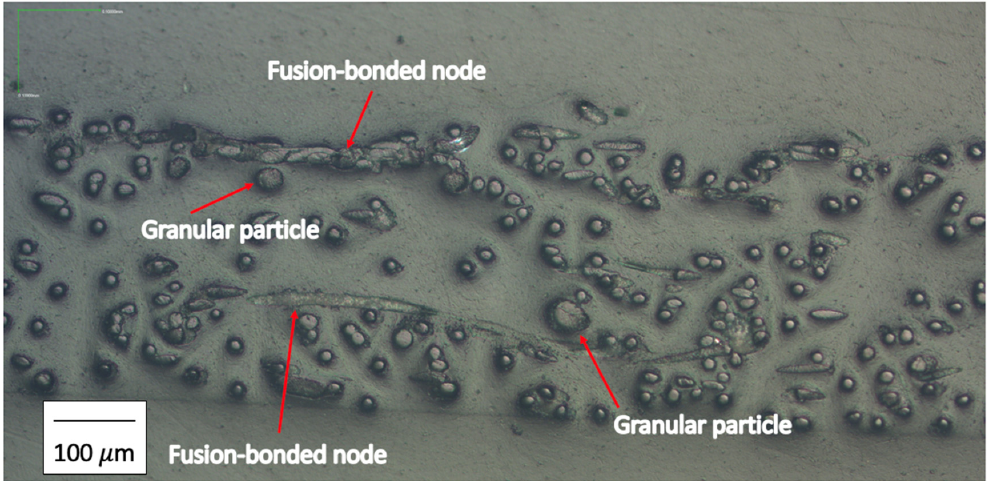
Figure 4. Sectional image of polyamide veil (four layers).